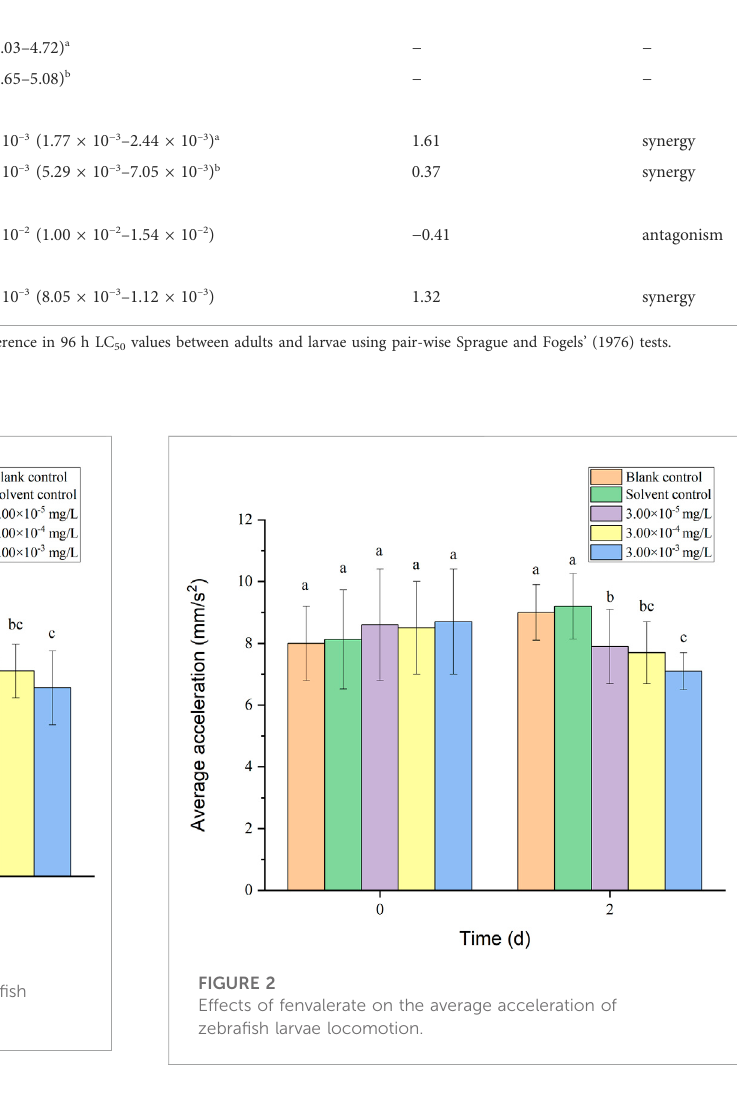
Data are expressed as the mean ± SD and different alphabets denote signi fi cant differences between the exposure treatments for each day ( p < 0.05, one-way ANOVA). Signi fi cant differences were found at 2d (F = 3.62, dfb = 4, dfw = 10). Data are expressed as the mean ± SD and different alphabets denote signi fi cant differences between the exposure treatments for each day ( p < 0.05, one-way ANOVA). Signi fi cant differences were found at 2d (F = 3.94, dfb = 4, dfw = 10). Data are expressed as the mean ± SD and different alphabets denote signi fi cant differences between the exposure treatments